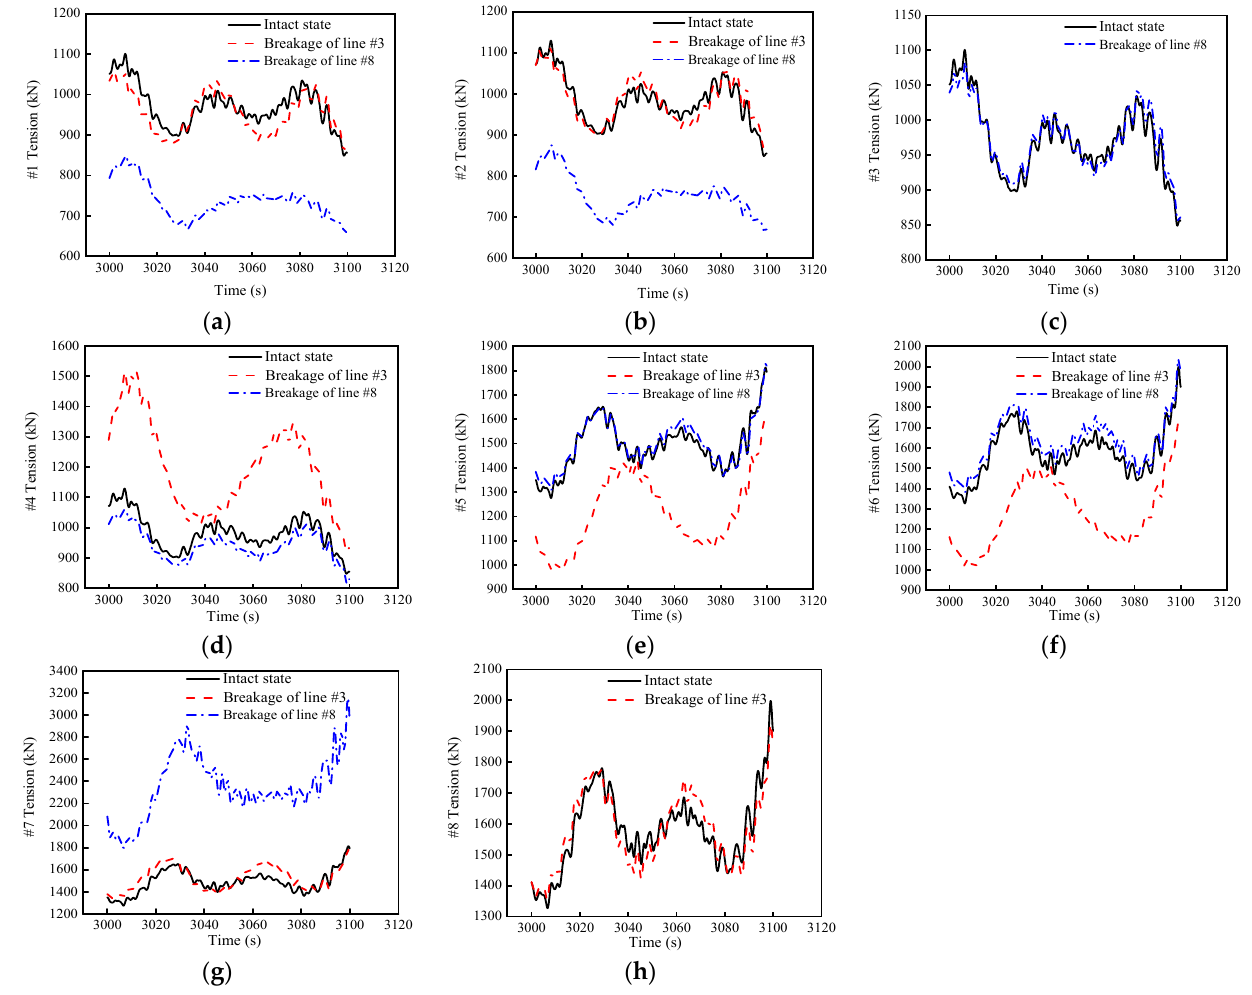
Figure 18. Mooring tension under different ECs for barge-type FOWT-AC: ( a ) Time histories of #1 tension; ( b ) Time histories of #2 tension; ( c ) Time histories of #3 tension; ( d ) Time histories of #4 tension; ( e ) Time histories of #5 tension, ( f ) Time histories of #6 tension; ( g ) Time histories of #7 tension; ( h ) Time histories of #8 tension.